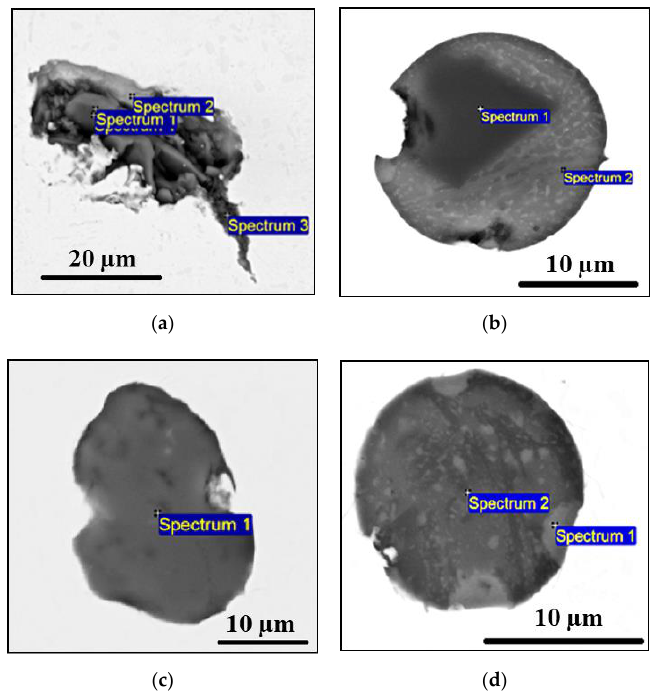
Figure 5. Typical large-sized oxide inclusions in different samples observed by two-dimensional (2-D) investigations on polished sample surface; ( a ) Types A and AM: Al 2 O 3 , Al 2 O 3 -MgO; ( b ) Type ACM: Al 2 O 3 -MgO + CaO-Al 2 O 3 + (CaS); ( c ) Type AC: Al 2 O 3 -CaO + (CaS); ( d ) Type AC: Al 2 O 3 -CaO + CaF 2 .